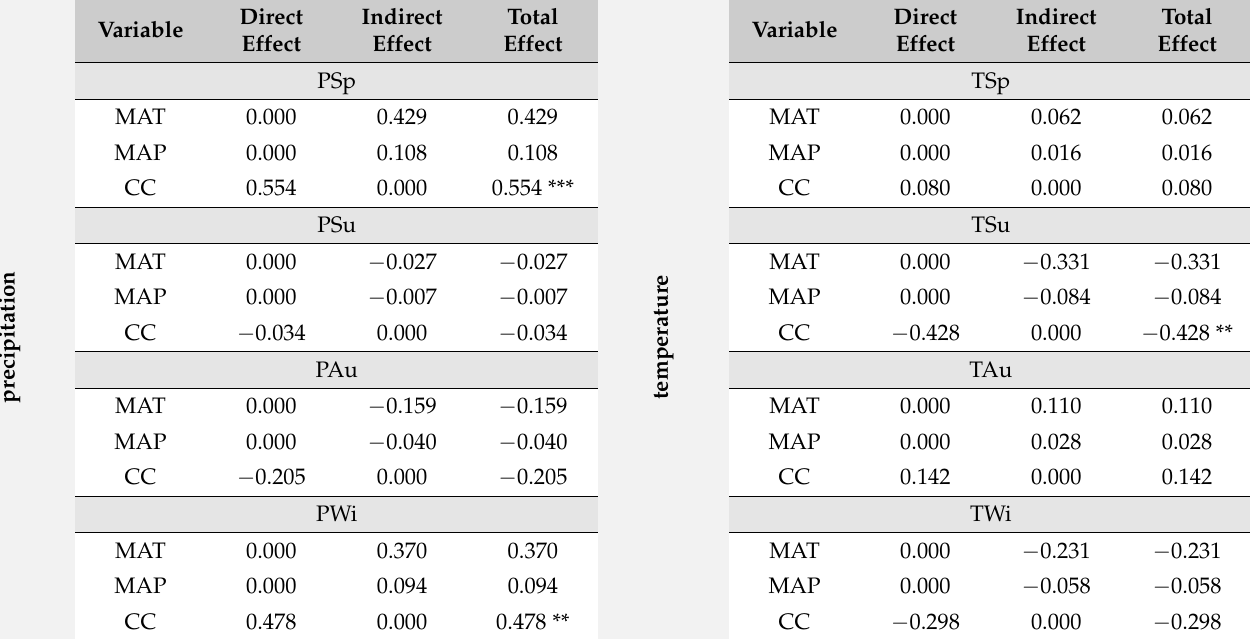
Table 2. Summary of the direct, indirect, and total effects of the variables (GW, MAP, MAT, PSp, PSu, PAu, PWi, TSp, TSu, TAu, and TWi) in the SEM of the Tibetan Plateau. The effects were calculated with standardized path